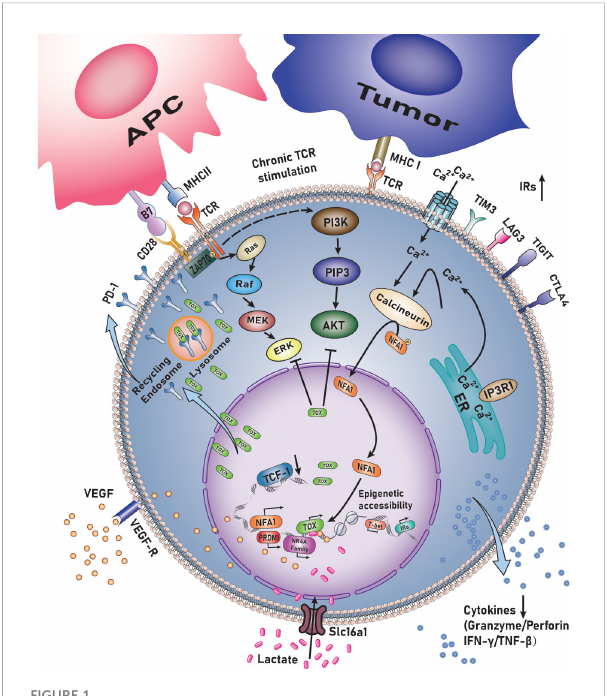
FIGURE 1 TOX regulates the exhaustion of CD8 + T